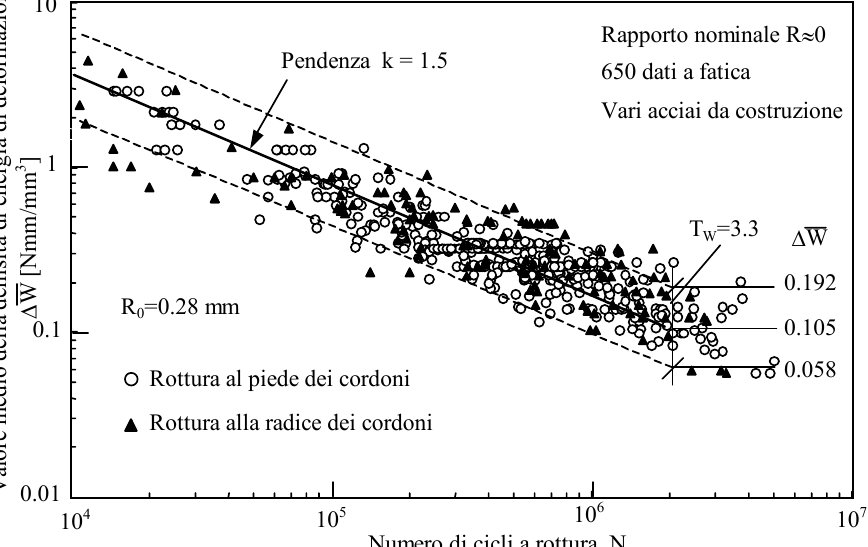
Figura 2. Resistenza a fatica in funzione del valore medio della densità di energia di deformazione presente in un settore semicir- colare di raggio R centrato sull’apice dell’intaglio a V [7-8]. Nel caso di giunti saldati realizzati con acciai da costruzione il rag- C gio critico R vale 0.28 C